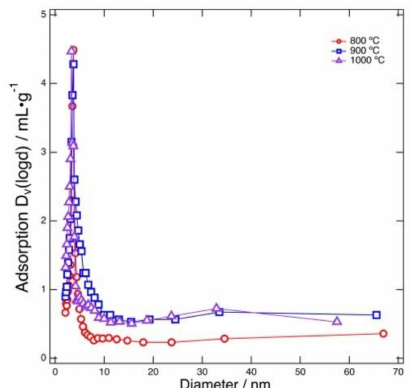
Figure 5. Pore size distributions of carbonized